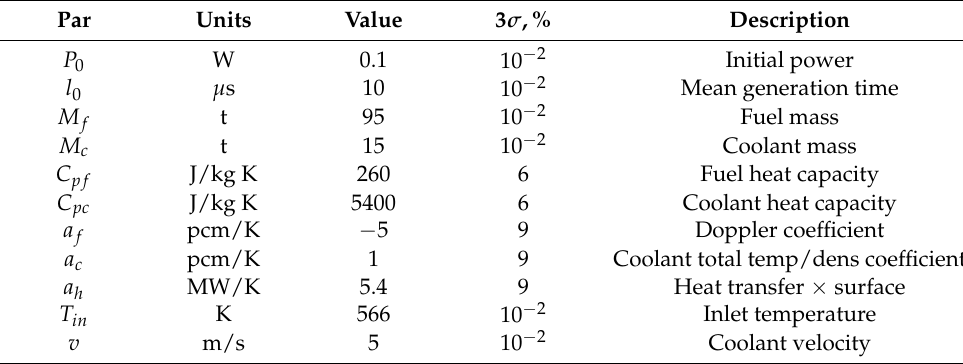
Table A3. Parameter values and uncertainties.